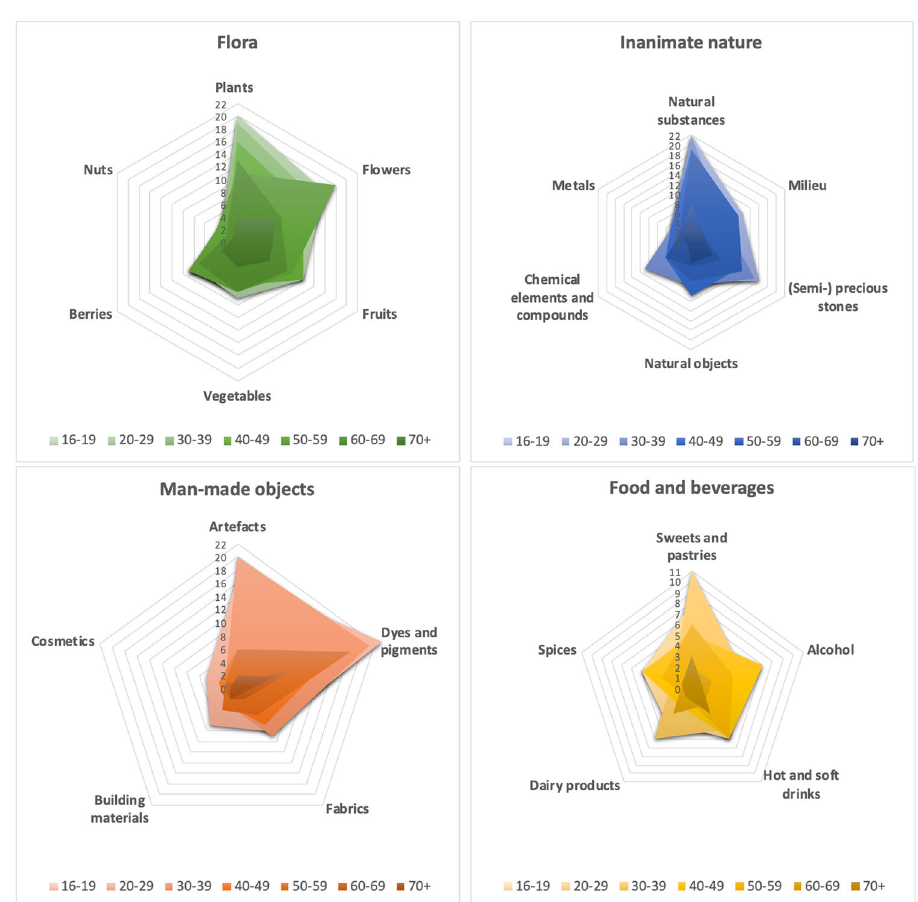
Fig. 12 Classes and categories of objects functioning as color-term referents. Occurrences in color naming by the seven age groups.